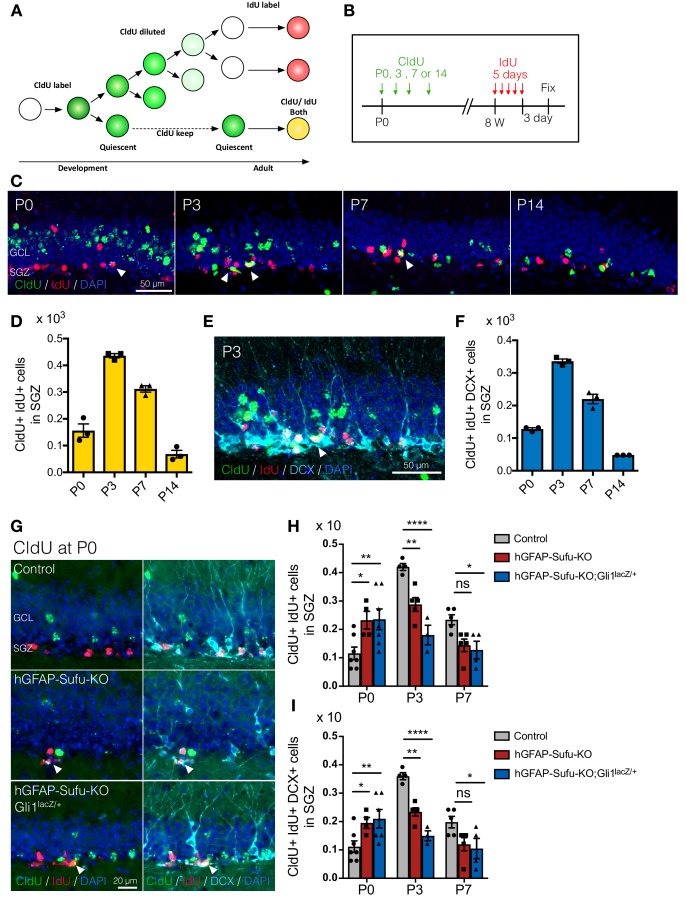
Deletion of Sufu prematurely induces the quiescent state transition.(A) Schematic illustration for labeling NSCs that established quiescent state during DG development using two thymidine analogs. CldU is diluted when cell divides. Thus CldU amount goes down if the cell continuously proliferates during DG development. However, if the cell becomes quiescent state, CldU amount is maintained until adult then the cell can be double-labeled with CldU and IdU if the CldU-labeled quiescent cell starts proliferation and incorporate IdU at adult. (B) Experimental scheme of CldU and IdU injection. CldU was injected at P0, P3, P7 or P14, and then IdU was injected for 5 days at 8 weeks old. The mice were sacrificed at 3 days after last IdU injection. (C) Representative immunofluorescence images for CldU (green), IdU (red) and DAPI (blue) in the SGZ of animals injected CldU at different stages. White arrowheads indicate the CldU/IdU double-labeled cells. (D) Quantification of CldU+/IdU +cells in the SGZ [n = 3 biological replicates per group]. (E) Representative immunofluorescence images for CldU (green), IdU (red), DCX (cyan) and DAPI (blue) in the SGZ of animal injected CldU at P3. White arrowheads indicate the CldU+/IdU+/DCX + cells. (F) Quantification of CldU+/IdU+/DCX + cells in the SGZ [n = 3 biological replicates per group]. (G) Representative immunofluorescence images for CldU (green), IdU (red), DCX (cyan) and DAPI (blue) in the SGZ of control, hGFAP-Sufu-KO and hGFAP-Sufu-KO;Gli1lacZ/+ mice injected CldU at P0. White arrowheads indicate the CldU+/IdU+/DCX + cells. (H,I) Quantification of CldU+/IdU +cells (H) and CldU+/IdU+/DCX + cells (I) in the SGZ [P0 CldU: Control, n = 7; hGFAP-Sufu-KO, n = 4; hGFAP-Sufu-KO;Gli1lacZ/+, n = 6; P3 CldU: Control, n = 4; hGFAP-Sufu-KO, n = 5; hGFAP-Sufu-KO;Gli1lacZ/+, n = 3; P7 CldU: Control, n = 5; hGFAP-Sufu-KO, n = 5; hGFAP-Sufu-KO;Gli1lacZ/+, n = 4]. Values represent mean ±SEM; ns: p>0.05, *p<0.05, **p<0.01, ****p<0.0001. ANOVA with Tukey post-hoc tests.10.7554/eLife.42918.025Figure 6—source data 1 .Extended numerical data and statistical analysis for Figure 6.